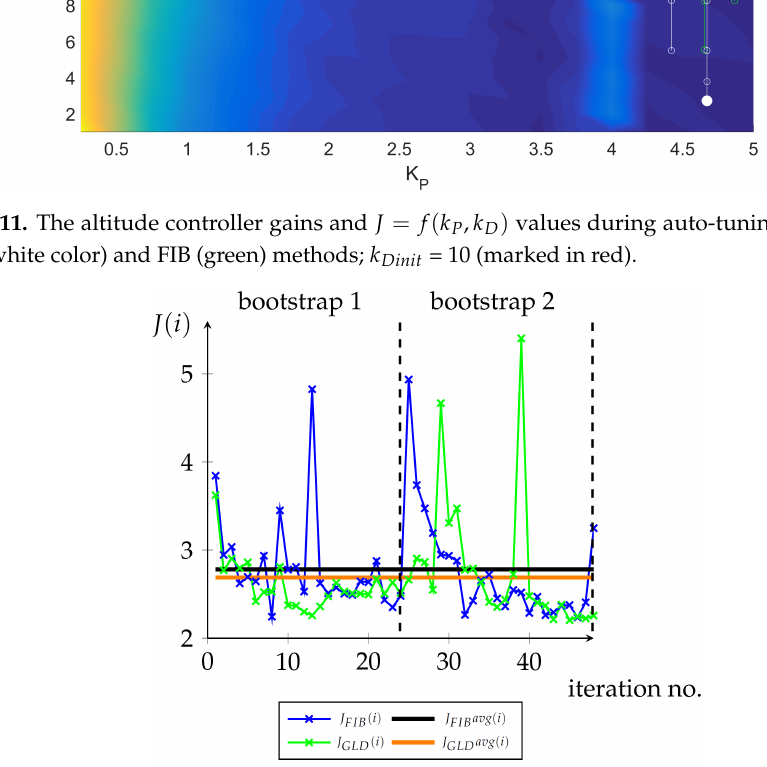
Figure 12. Time courses for the GLD and FIB tuning process in real-world conditions.